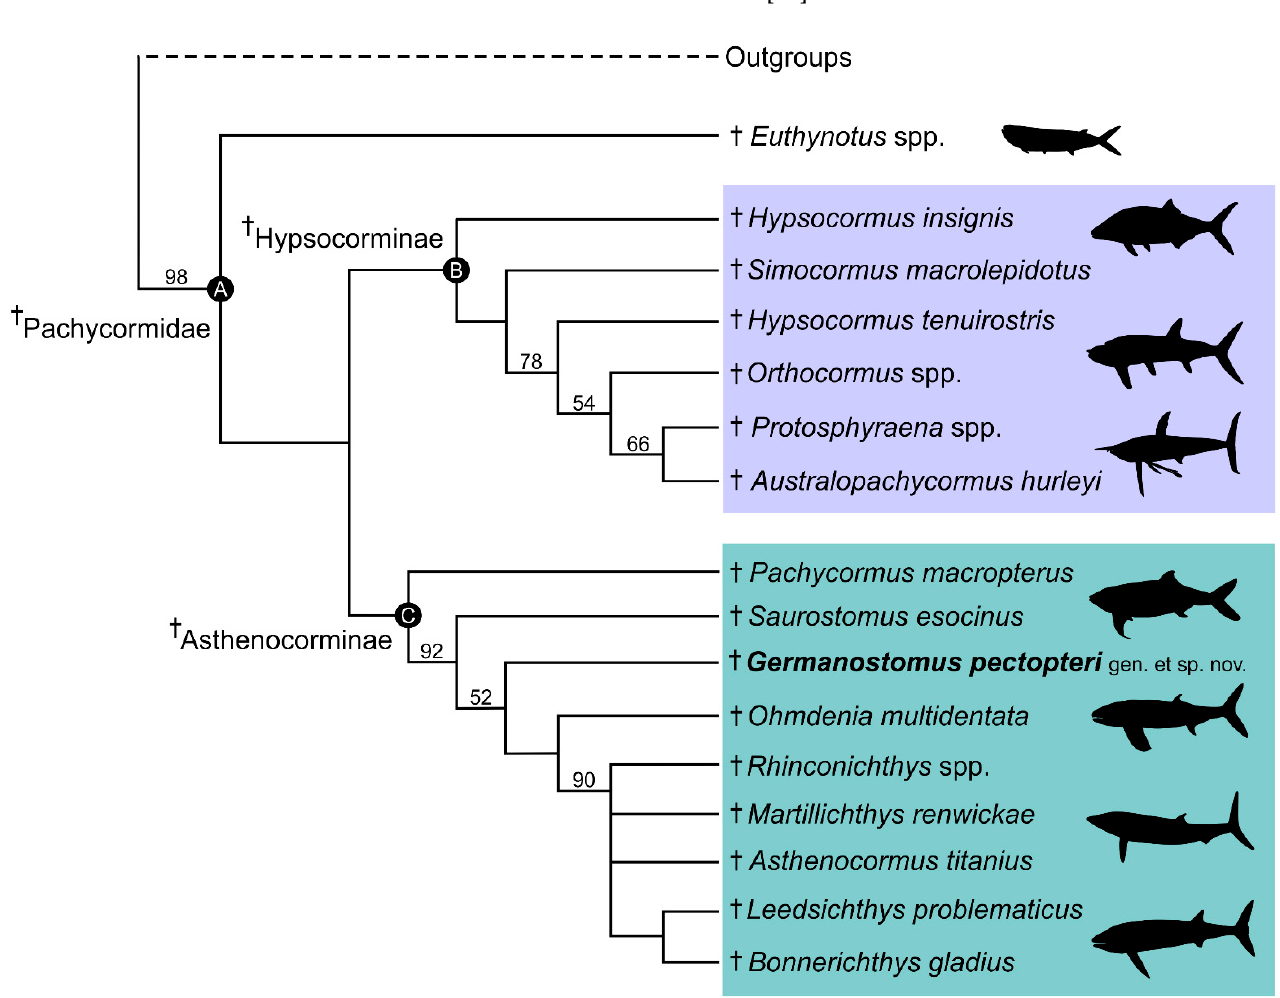
Figure 9. Strict consensus of 12 most parsimonious trees (MPTs) composed of 30 taxa and 129 characters based on the matrix of Friedman [16], indicating the position of Germanostomus gen. et sp. nov. within Asthenocorminae. Jackknife support values greater than 50% are indicated. Colour boxes indicate grouping of the two sub-family clades, Hypsocorminae (node 2) and Asthenocorminae (node 3). Pachycormidae (node 1) includes both Hypsocorminae and Asthenocorminae in addition to the basal genus Euthynotus . Non-pachycormid outgroups have been pruned from the figure (see Supplementary data for full list and expanded cladogram). All silhouettes except for Leedsichthys (redrawn from Reference [90]) were produced by the authors.